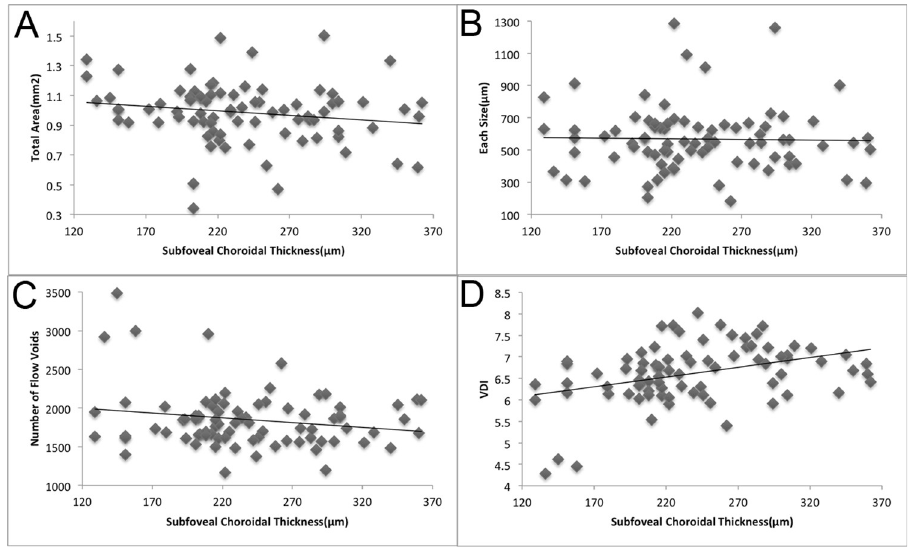
Fig 6. Correlations among subfoveal choroidal thickness, total area, size, and number of flow voids, and the VDI. A. Correlation between the total area of flow voids and subfoveal choroidal thickness. No significant correlation is observed between the total area of flow voids and subfoveal choroidal thickness (p = 0.125). B. Correlation between the size of flow voids and subfoveal choroidal thickness. No significant correlation is observed between the size of flow voids and subfoveal choroidal thickness (p = 0.838). C. Correlation between the number of flow voids and subfoveal choroidal thickness. No significant correlation is observed between the number of flow voids and subfoveal choroidal thickness (p = 0.093). D. Correlation between the VDI and subfoveal choroidal thickness. The VDI correlates positively with subfoveal choroidal thickness (p = 0.001, R = 0.377).